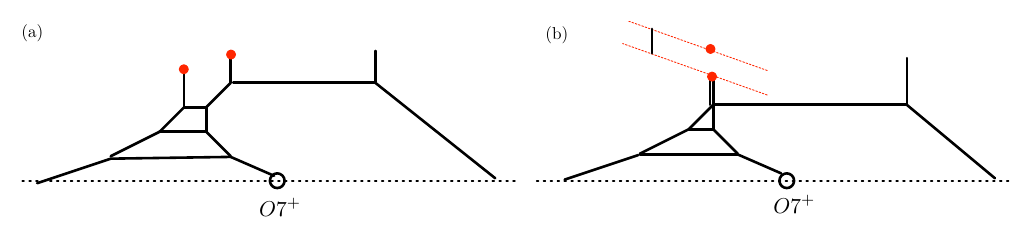
Figure 15. (a) A 5-brane web for SU(4) 0 +1 Sym . (b) A non-perturbative Higgsing by putting two NS 5 -branes together and perform a Higgsing such that the NS 5 -brane ending two (0 , 1) 7-branes is taken away along the x 7 , 8 , 9 -directions.